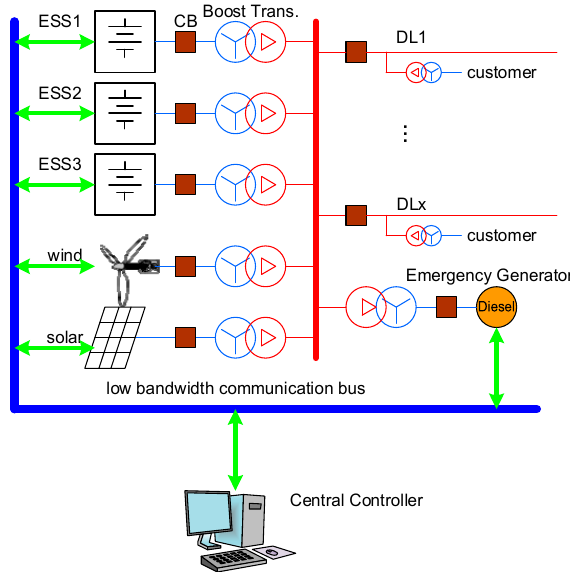
Figure 1. An MG based on renewables and an ESS with a central controller.